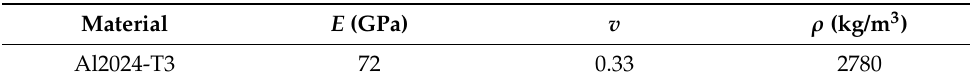
Figure 5. Dimension of the plate structure and crack location. Table 1. Mechanical properties. Table 1. Mechanical